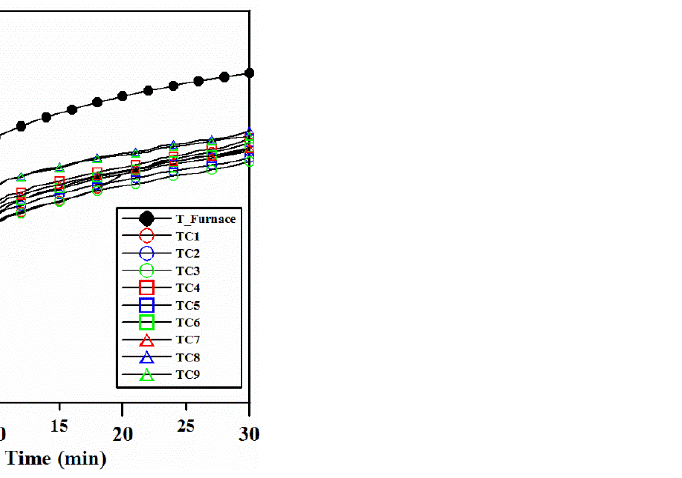
Figure 7. The temperature distribution on the unexposed surface of the fireproof curtain without a water film.